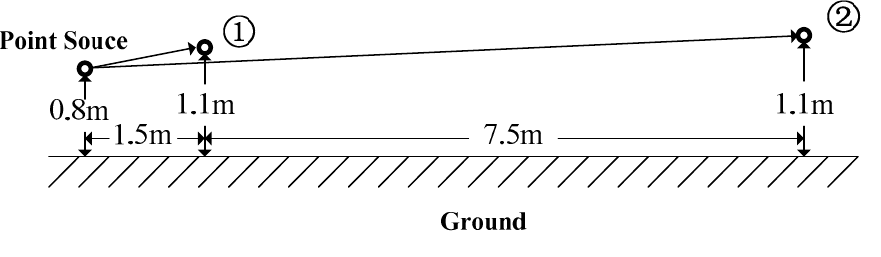
Figure 4. Noise attenuation experiment with distance.